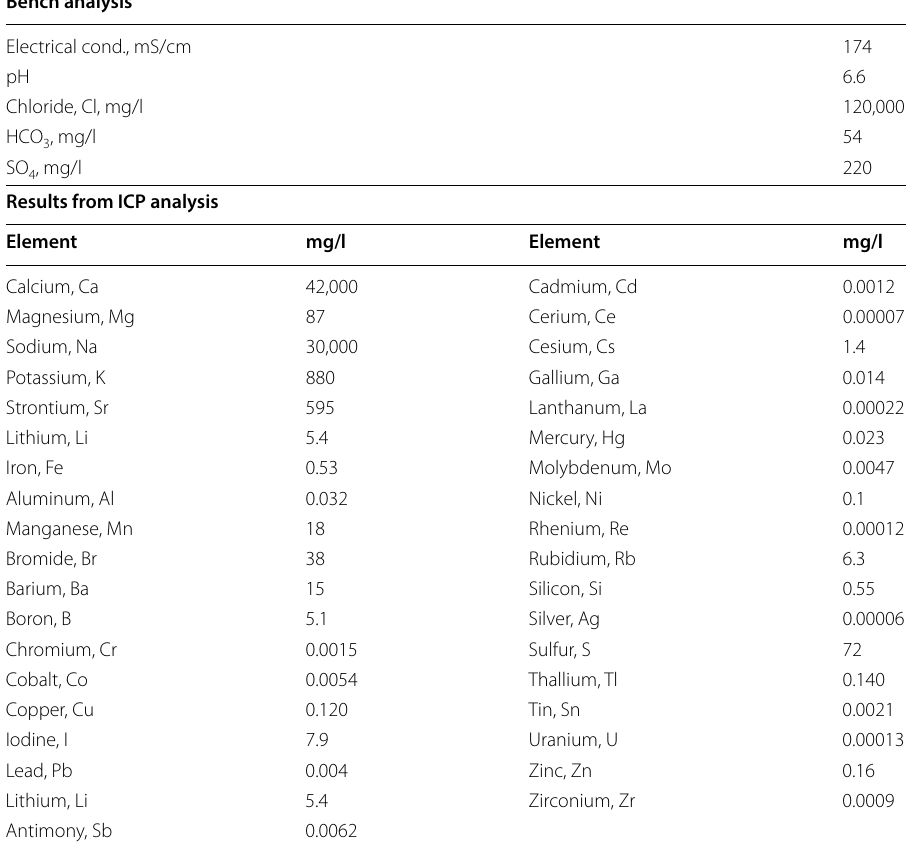
Table 5 Summary of the results from the chemical analyses of the formation fluid sampled from the DGE-1 crystalline basement section between 3198 and 3701.8